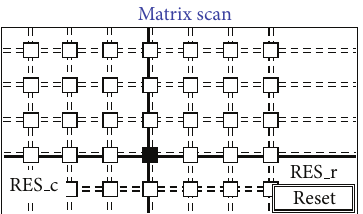
Figure 14: Last reset on the